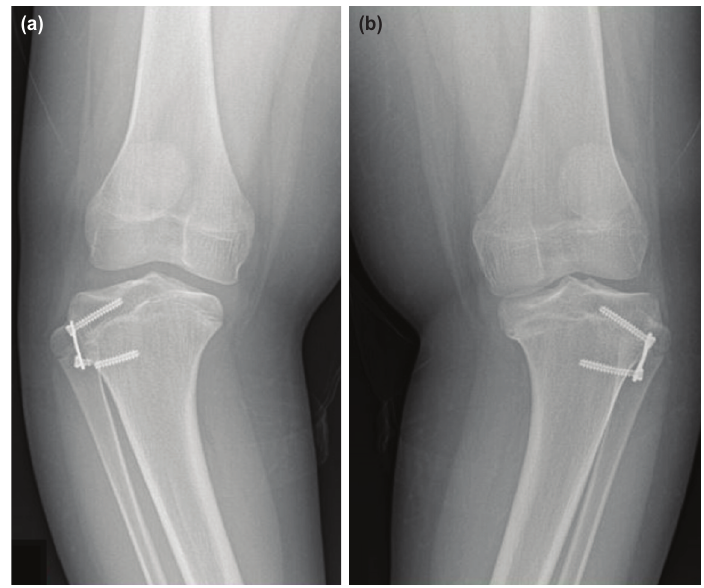
Anteroposterior view knee radiographs of a 16-year old boy with bilateral tibia vara and a BMI of 32. He was treated with 8 Fig. 3: plates at the age of 13 years (Case 9). (a) Broken metaphyseal screw in the right tibia. (b) Left tibia metaphyseal screw was bent and subsequently broke prior to removal.